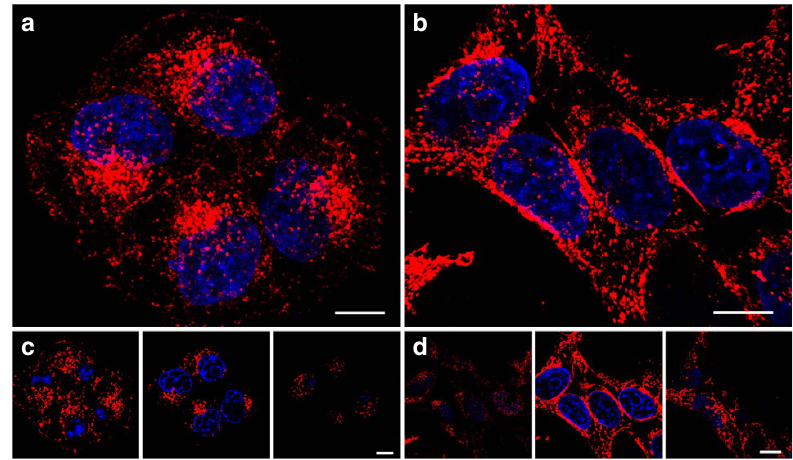
Figure 5 | Intracellular NIR-emission profile. CLSM images showing intracellular localization of pH-responsive compound 2 (10 m M, red) and nuclear counterstain Hoechst 33342 (blue) in fixed ( a , c ) HeLa Kyoto and ( b , d ) HEK293 cell lines. Bottom: three corresponding representative slices of the Z -stack for each cell type. Scale bars, 10 m